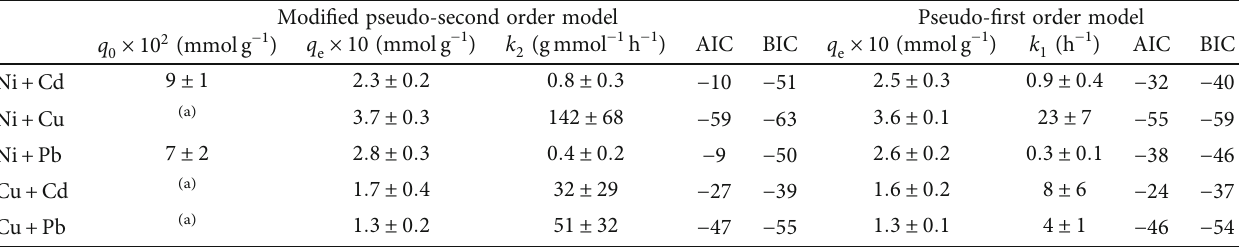
Table 4: Fitting parameters of the kinetic models for the total adsorption in binary mixtures. Modi fi ed pseudo-second order